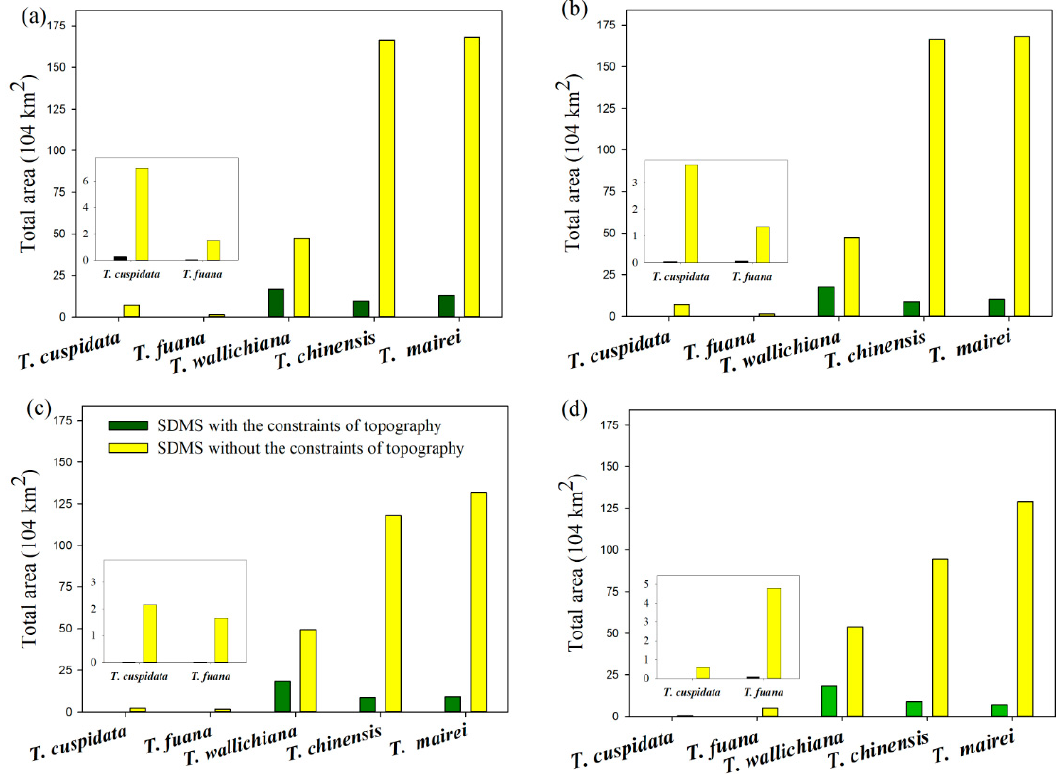
Figure 4. Total distribution area of each Taxus species under current ( a ) and future conditions (RCP 2.6 ( b ), RCP 4.5 ( c ), and RCP 8.5 ( d ) scenarios in 2070).